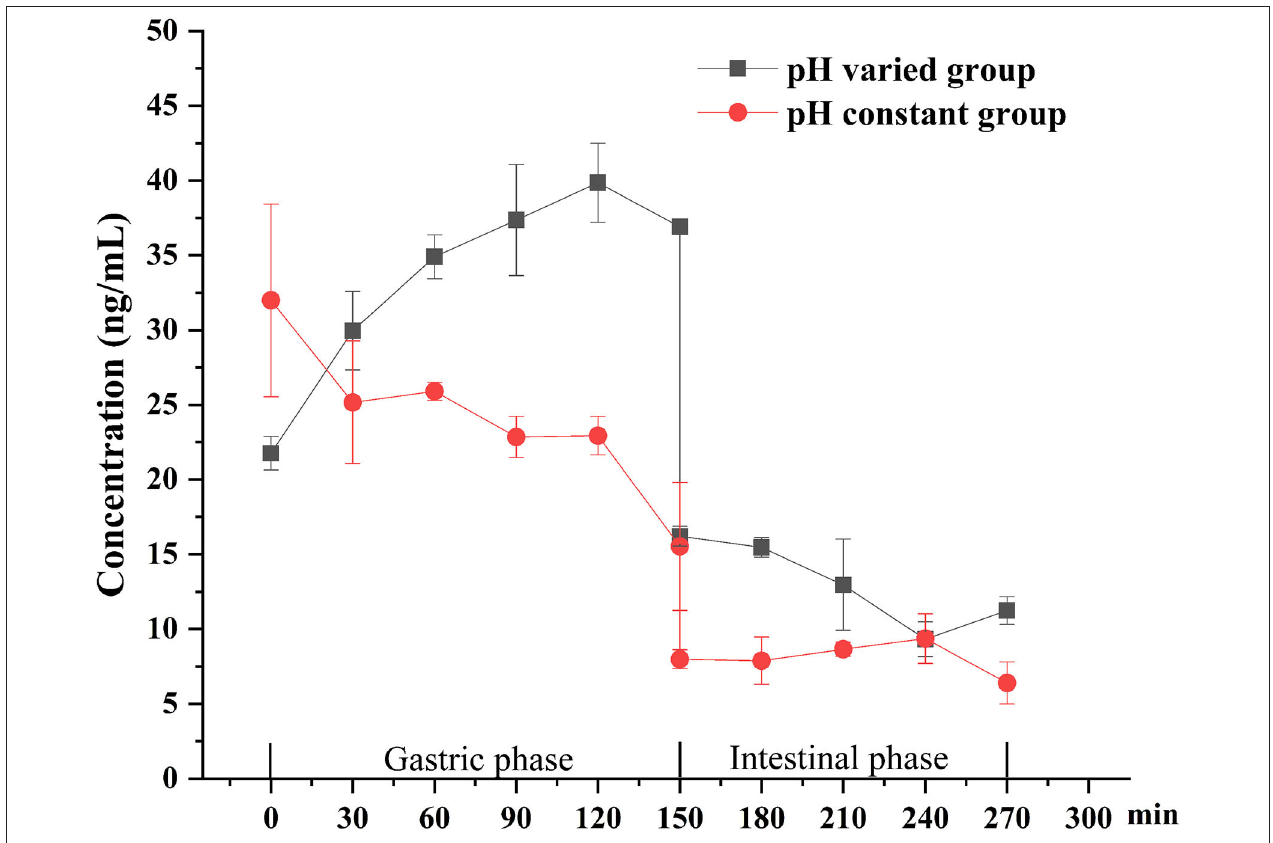
FIGURE 6 | Concentration changes of DEL in digestive juice during simulated digestion with different